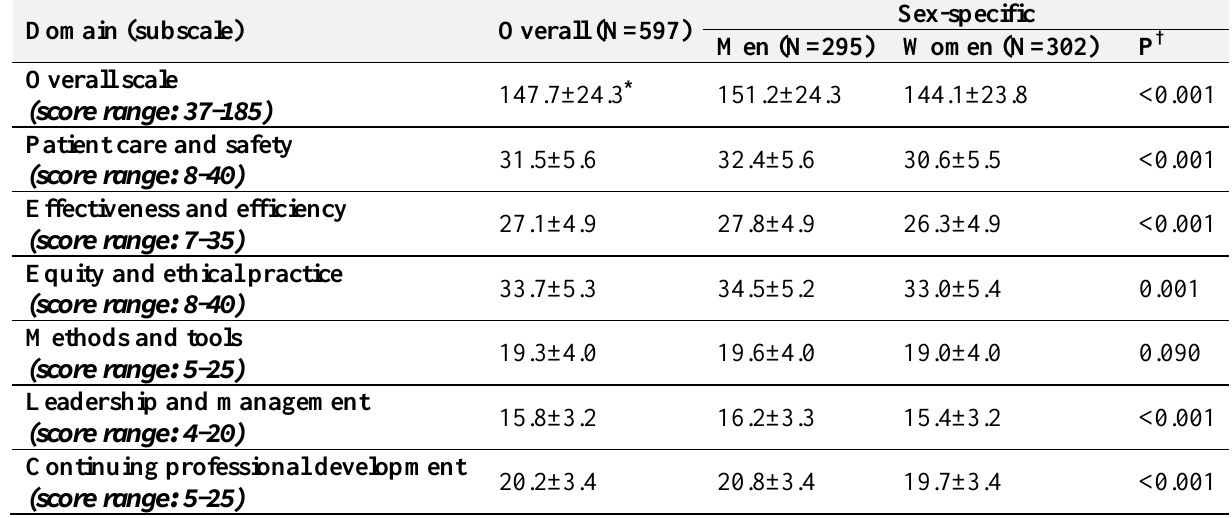
Table 3. Summary score of each domain (subscale) of the instrument by sex Domain